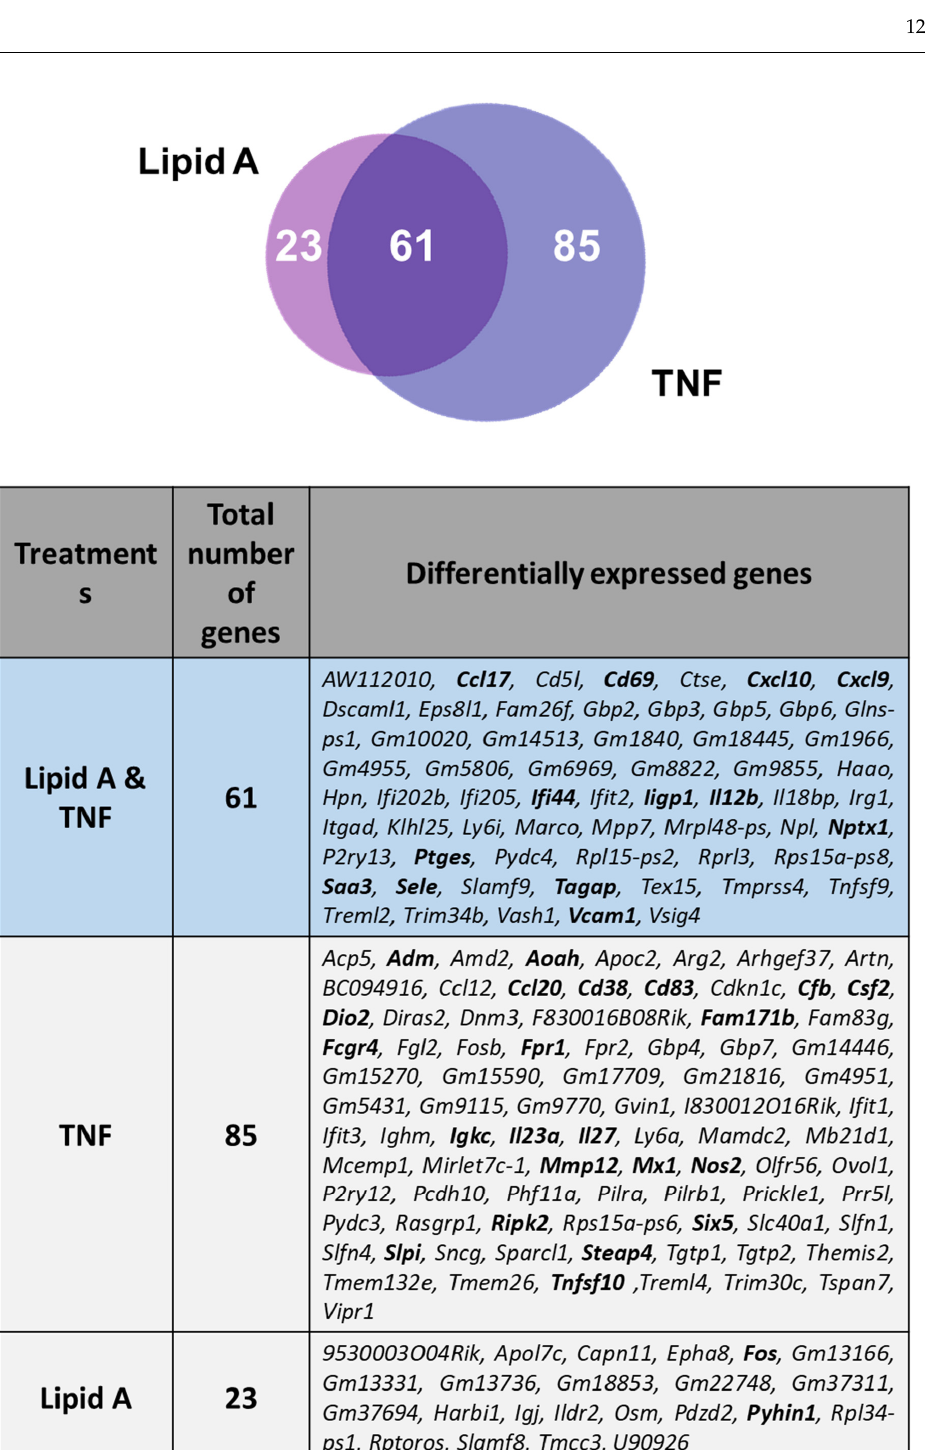
Figure 7. Distribution of differentially expressed genes comparing Lipid A and TNF treatments of p65 ‐ DsRedxp/I κ B α‐ eGFP BMDMs. Venn diagram illustrating the distribution of differentially